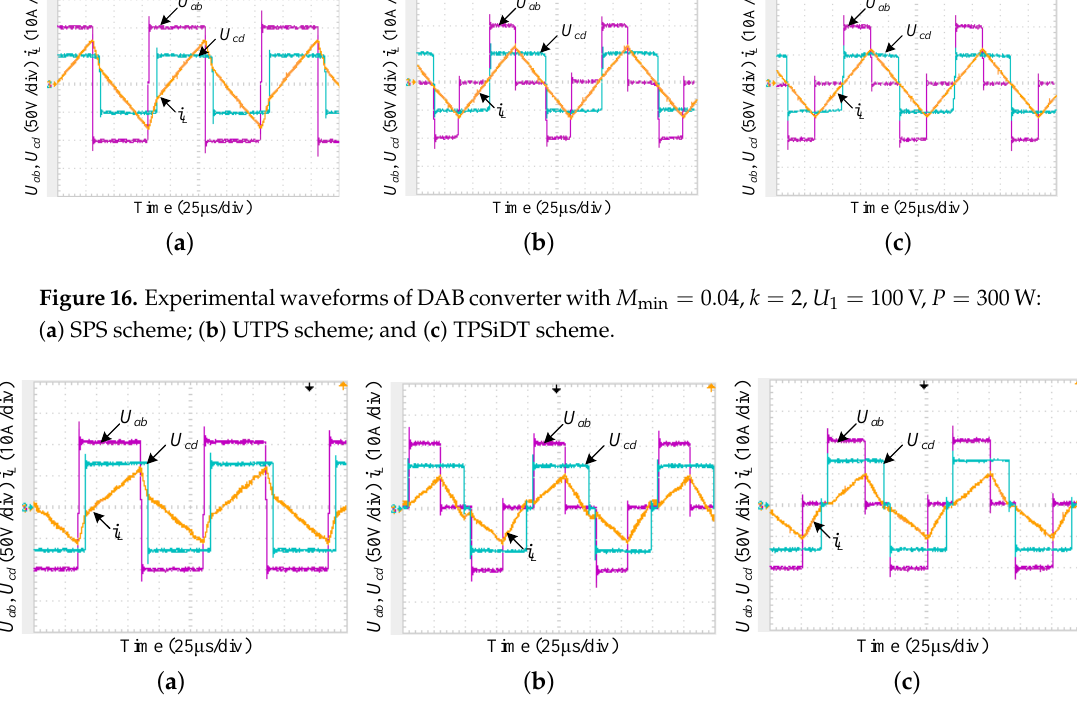
Figure 17. Experimental waveforms of DAB converter with M min = 0.1, k = 1.5, U 1 = 100 V,